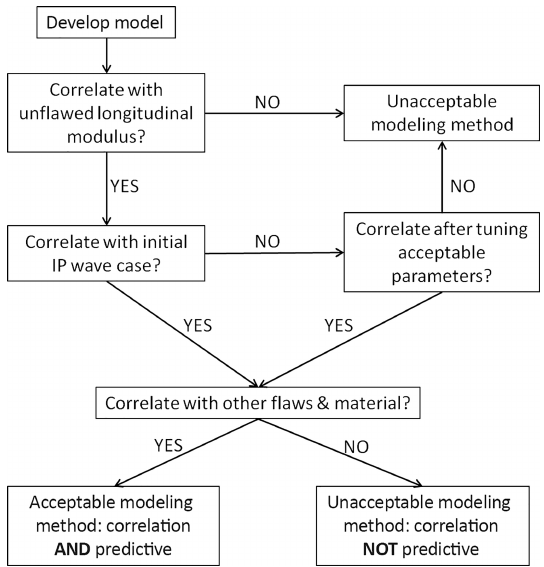
Figure 6. Systematic flow of approach to determine acceptability of each